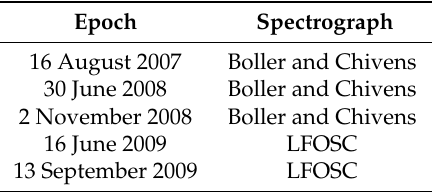
Table 1. Epoch of observations and the spectrograph used.